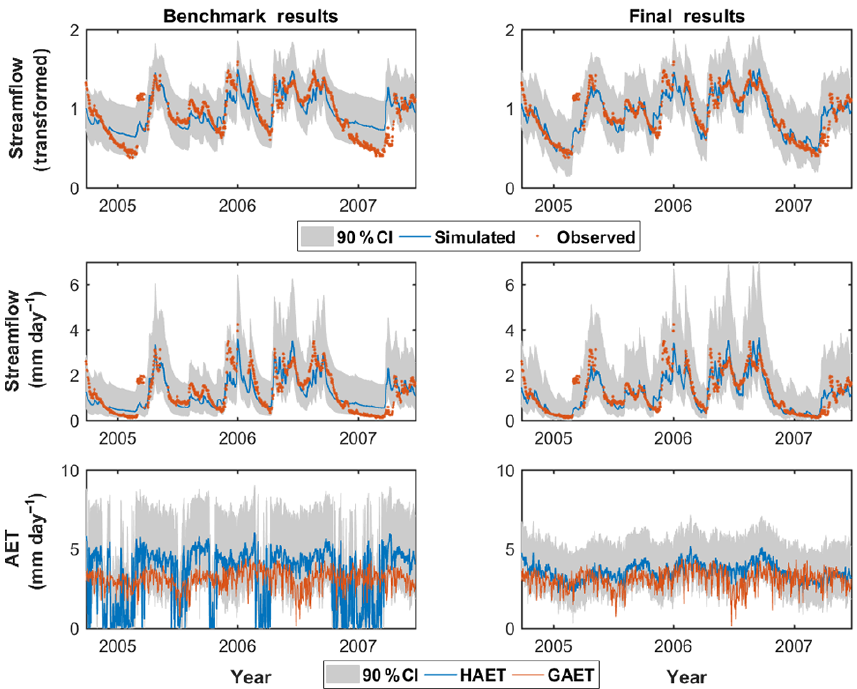
Figure 12. Time-series plots of streamflow ( λ -transformed and actual) and AET for the benchmark and the final steps. For clarity, we only show a window of 1000